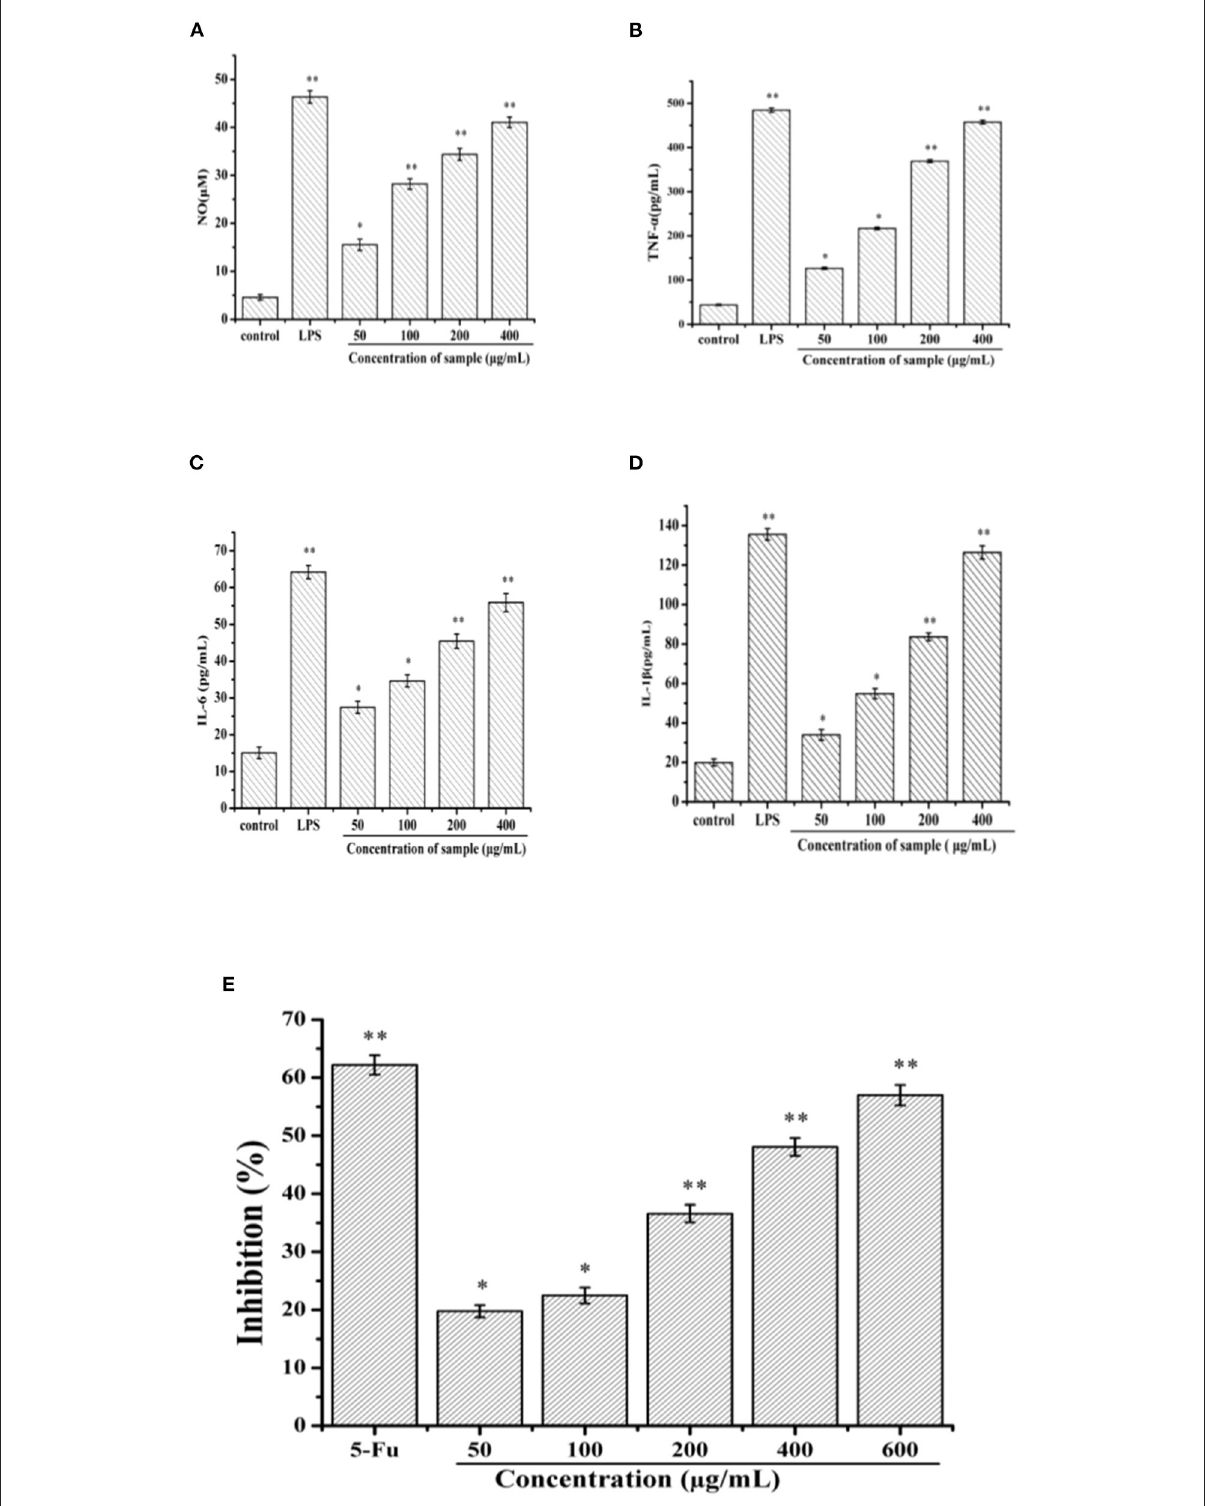
FIGURE6 Effects of SVPS2 on the (A) NO, (B) TNF- α , (C) IL-6, and (D) IL-1 β secretion of RAW264.7 macrophages. (E) Cell viability of HT-29 treated with SVPS2. * p < 0.05, ** p < 0.01 compared to the control group.